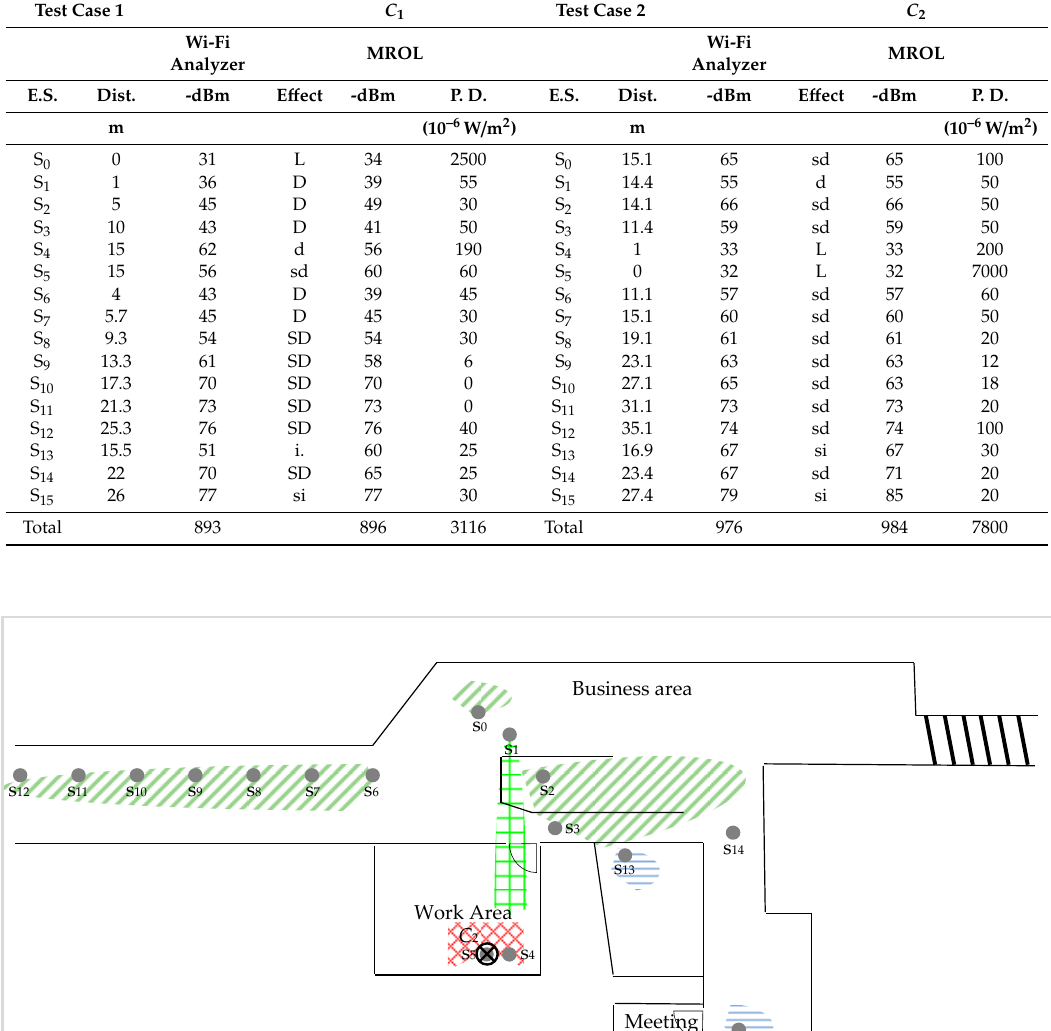
Table 2. Comparison of electromagnetic wave signal strength and total electromagnetic wave power density for S 0 , S 1 , ... , and S 15 to C 1 and C 2 .